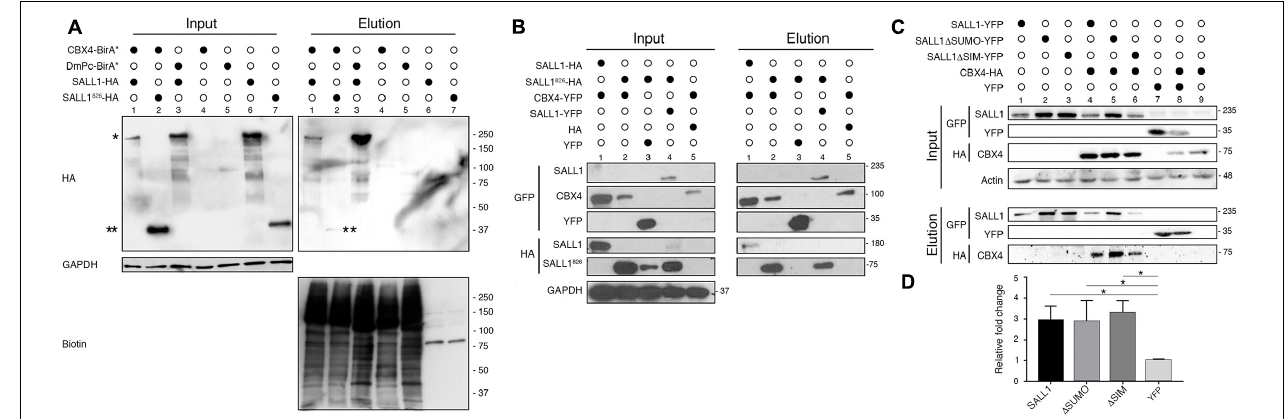
FIGURE 2 | SALL1 interacts with CBX4 in a SUMOylation-independent manner. (A) Validation of the interaction between human SALL1 and human CBX4 or Drosophila melanogaster Pc proteins using BioID-based biotin pulldown in transfected HEK 293FT cells. In the Input panel, the relative expression of the HA-tagged SALL1 proteins (the full-length protein or a TBS-related truncation mutant) is shown. One asterisk indicates SALL1-HA, while two asterisks indicate SALL1 826 -HA. Negative controls (single expression of each individual protein) are shown in lanes 4–7. Anti-GAPDH was used as loading control. As shown in the Elution panel, CBX4-BirA* interact preferentially with full-length SALL1-HA (lane 1). Anti-biotin blot shows the efficiency of the different pulldowns. (B) Validation of the interaction between SALL1 and CBX4 using GFP-Trap. The Input panel shows the expression of epitope-tagged SALL1 and CBX4 proteins in transfected HEK 293FT cells. YFP alone and HA empty vector were used as controls. Lanes 1 and 2 of the Elution panel, show that CBX4 interacts with SALL1 full length and the truncated form. (C) SUMO-related SALL1 mutants interact with CBX4. Western blot analysis of proteins extracted from HEK 293FT cells transfected with the indicated plasmids. Pulldowns were performed using GFP-Trap. As shown in the Elution panel (lanes 4, 5, and 6), interaction between CBX4 and WT SALL1 or SALL1 mutants was readily detected in all blot images. (D) Graph showing that CBX4 levels increase when co-expressed with WT SALL1-YFP, SALL1 (cid:49) SUMO-YFP, or SALL1 (cid:49) SIM-YFP. The intensity of CBX4 bands in blots was quantified using ImageJ, normalized to b-Actin and reported as fold change relative to the YFP alone control. The mean plus SEM of three independent experiments is plotted. P -values were calculated using Mann–Whitney test. * P -value < 0.05. (A–C) Antibodies used are indicated to the left. Molecular weight markers are indicated to the right in